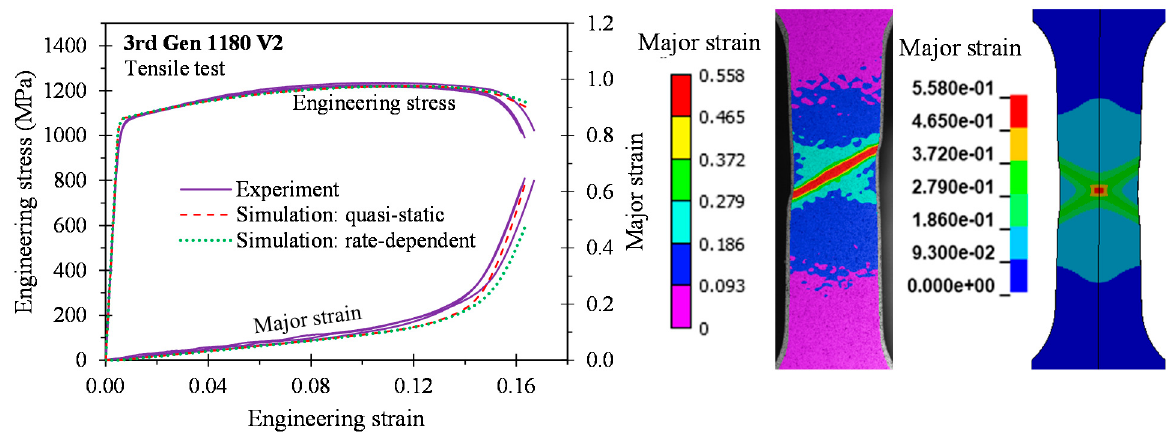
Figure 18. Comparison of the global and local response in 3D tensile simulations for the 3rd Gen 1180 V2.